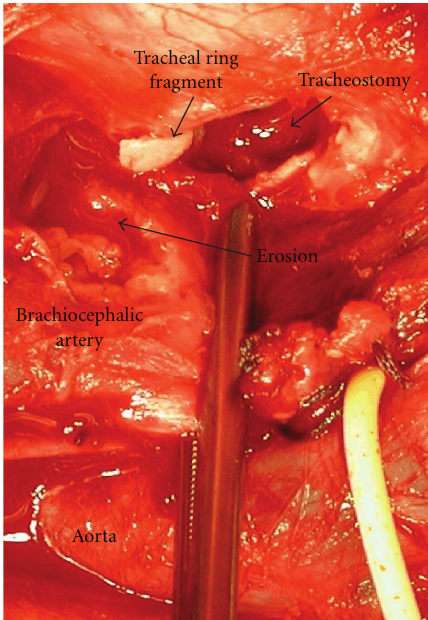
Figure 1: Intraoperative view (Case 1). Please note the tip of the tracheal ring fragment near the dorsal wall lesion of the brachiocephalic artery.